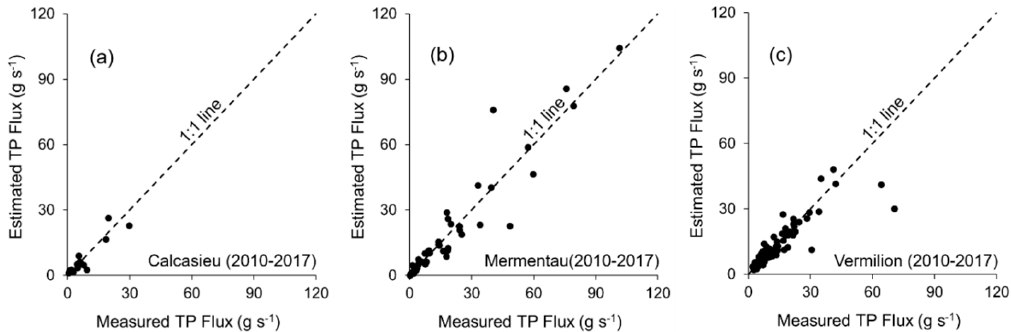
Figure A2. Relationship between measured TP fluxes and estimated TP fluxes using regression equations (Equation (1)) for the Calcasieu (Kinder, ( a )), Mermentau ( b ), and Vermilion ( c ) Rivers from 2010 to 2017.